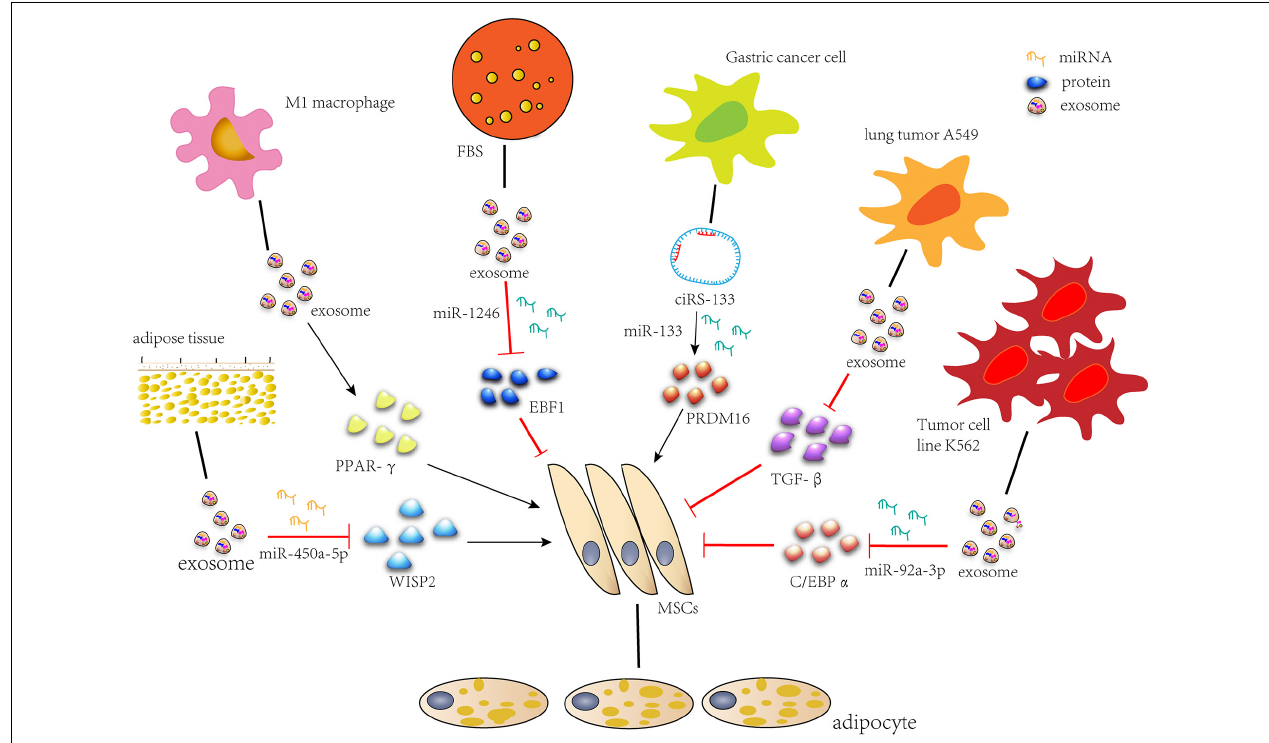
FIGURE 2 | Exosomes regulate adipogenic differentiation. miR-450a-5p contained in exosomes from rat adipose tissue promotes adipogenesis by inhibiting the expression of WISP2. Exosomes secreted by M1 macrophages significantly promote lipid droplet formation by up-regulating the expression of PPAR-gamma gene. miR-1246 in FBS secreted exosomes inhibits adipogenic differentiation by targeting EBF1. Gastric cancer exosome-delivered ciRS-133 promotes adipogenic differentiation by suppressing the functionality of miR-133 and promoting PRDM16 expression. Lung tumor cell A549-derived exosomes inhibit adipogenic differentiation via TGF β signaling pathway. miR-92a-3p in K562 cell line inhibits adipogenesis of ADSC by reducing C/EBP α expression after